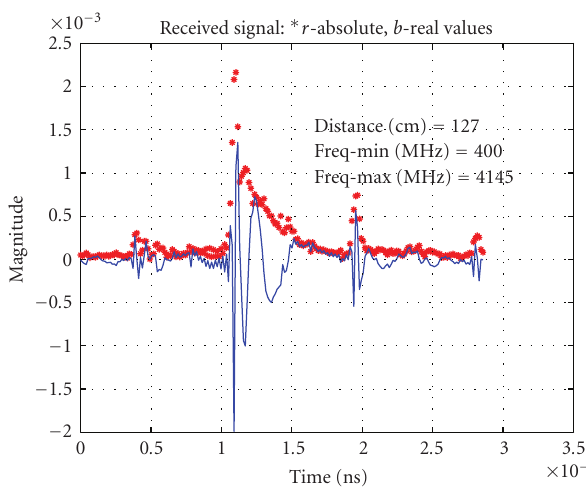
Figure 3: The received signals, in time domain, for 3745 MHz frequency span (108 frequencies—last 20 removed).